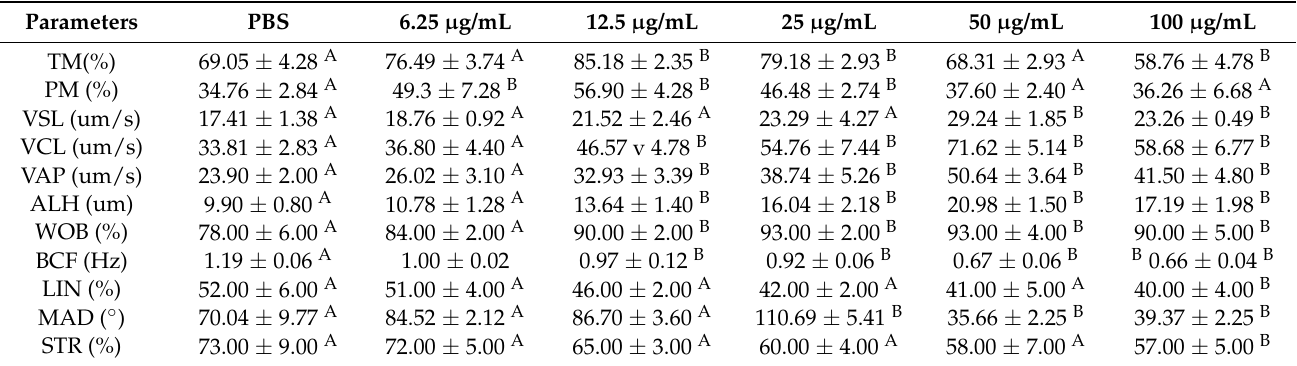
Table 2. Effects of recombinant pBD129 protein of E. coli expression system on sperm motility under E. coli DH5 α contamination.